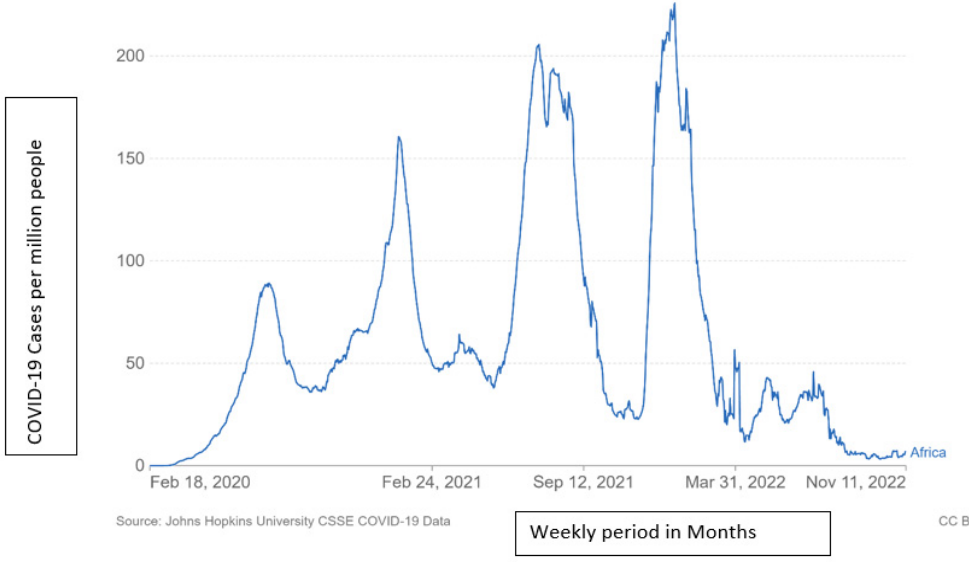
Figure 1. This figure is the daily COVID-19 documented cases per million persons in Africa between